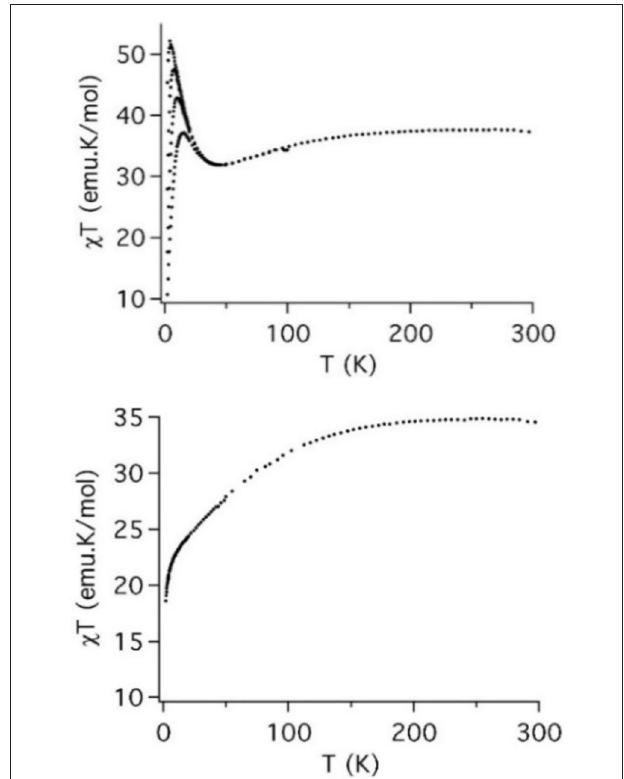
FIGURE 6 | Thermal dependence of χ m T for Q-3 (left) and Q-4 (right) at different fields (0.1, 0.5, 1 and 2T for Q-3 ; 0.1T for Q-4 ) in the range 2–300K.